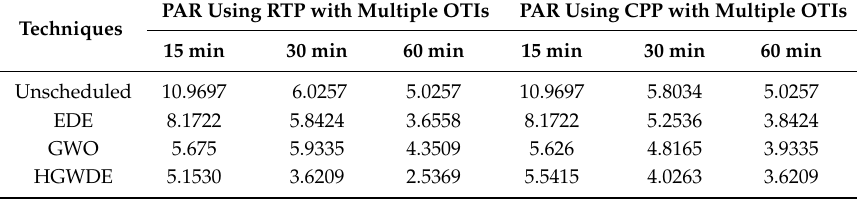
Table 8. PAR comparison of different techniques for 24